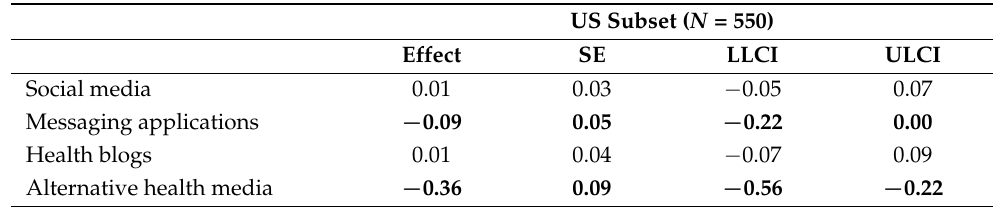
Table A2. The mediation effect of media reliance for COVID-19 news on vaccination behavior (US